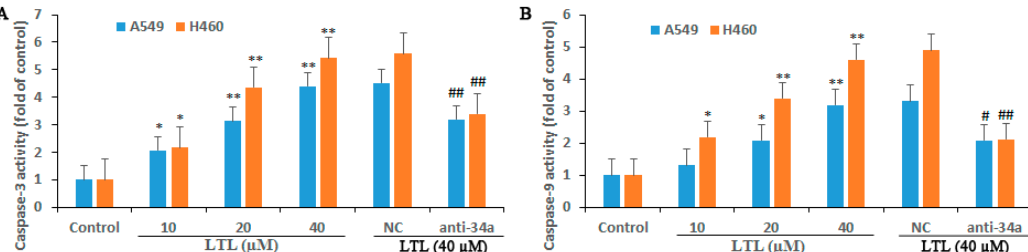
Figure 10. Effect of miR-34a-5p inhibition on apoptosis-related caspase activation in vitro. Caspase-3 ( A ) and Caspase-9 ( B ) activities were determined using colorimetric assay kits as described in the method section for A549 and H460 cell lines treated with anti-34a (LV-hsa-miR-34a-5p-inhibition) or NC (negative control) after LTL treatment (10, 20, or 40 μ M) for 48 h. The results are expressed as means ± SD of three independent experiments. * p < 0.05, ** p < 0.01, compared with control group; # p < 0.05, ## p < 0.01, compared with NC + LTL (40 μ M) group.